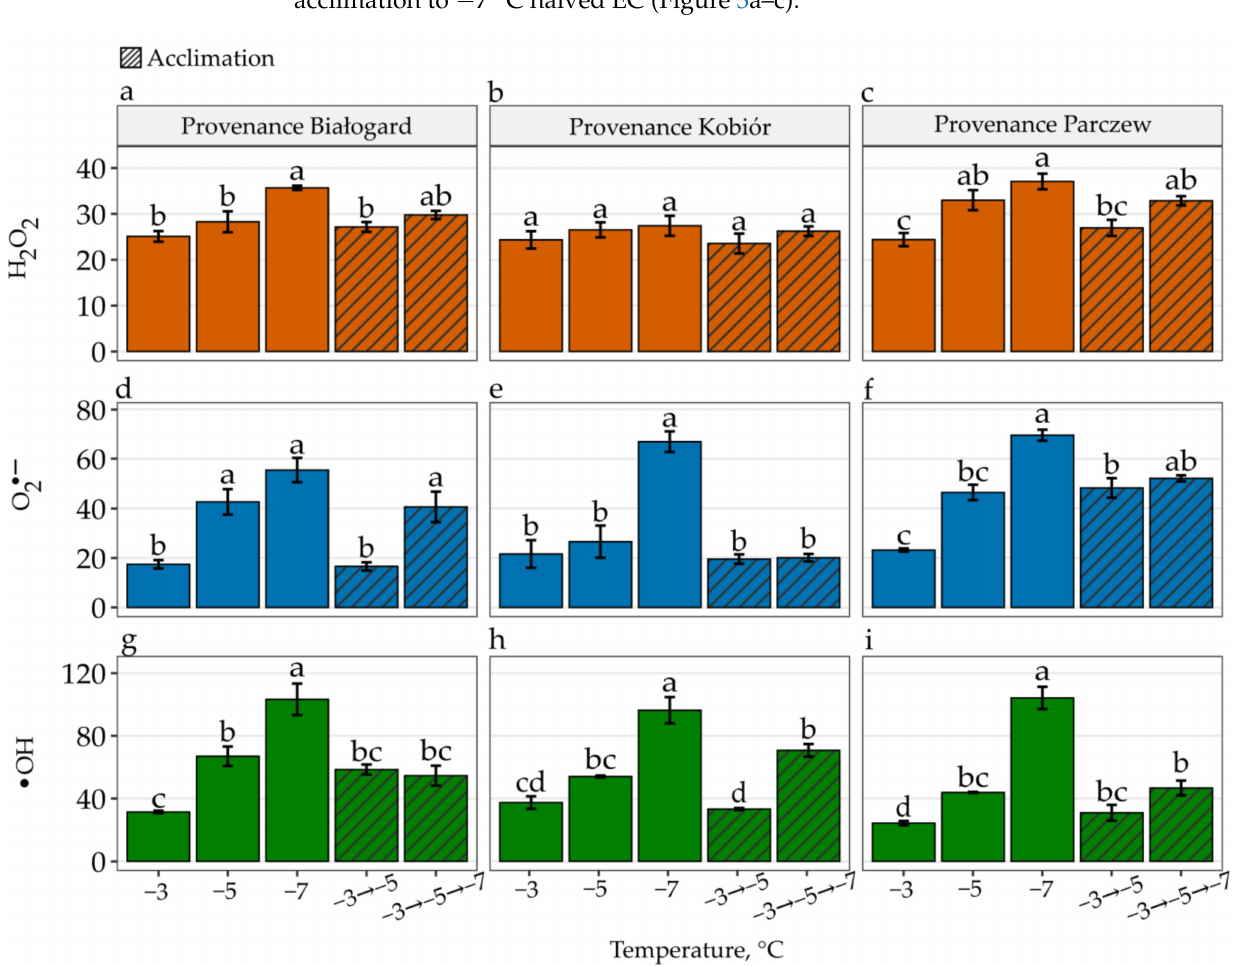
Figure 2. Measurements of ROS release levels ( a – c ) hydrogen peroxide (H 2 O 2 ), ( d – f ) superoxide anion radical (O 2 •− ) and ( g – i ) hydroxyl radical ( • OH) in embryonic axes of pedunculate oak acorns stored at single temperature ( − 3 ◦ C, − 5 ◦ C, or − 7 ◦ C) and at combined temperatures ( − 3 ◦ C → − 5 ◦ C or − 3 ◦ C → − 5 ◦ C →− 7 ◦ C) and originating from three provenances: Białogard, Kobi ó r and Parczew. Units: H 2 O 2 [nmol g − 1 FW h − 1 ], O 2 •− [ ∆ A nmol g − 1 FW h − 1 ], • OH [RFU 10 3 g − 1 FW h − 1 ]. Data are the means of six independent replicates ± the SE. Identical letters indicate groups not significantly differentiated according to Tukey’s